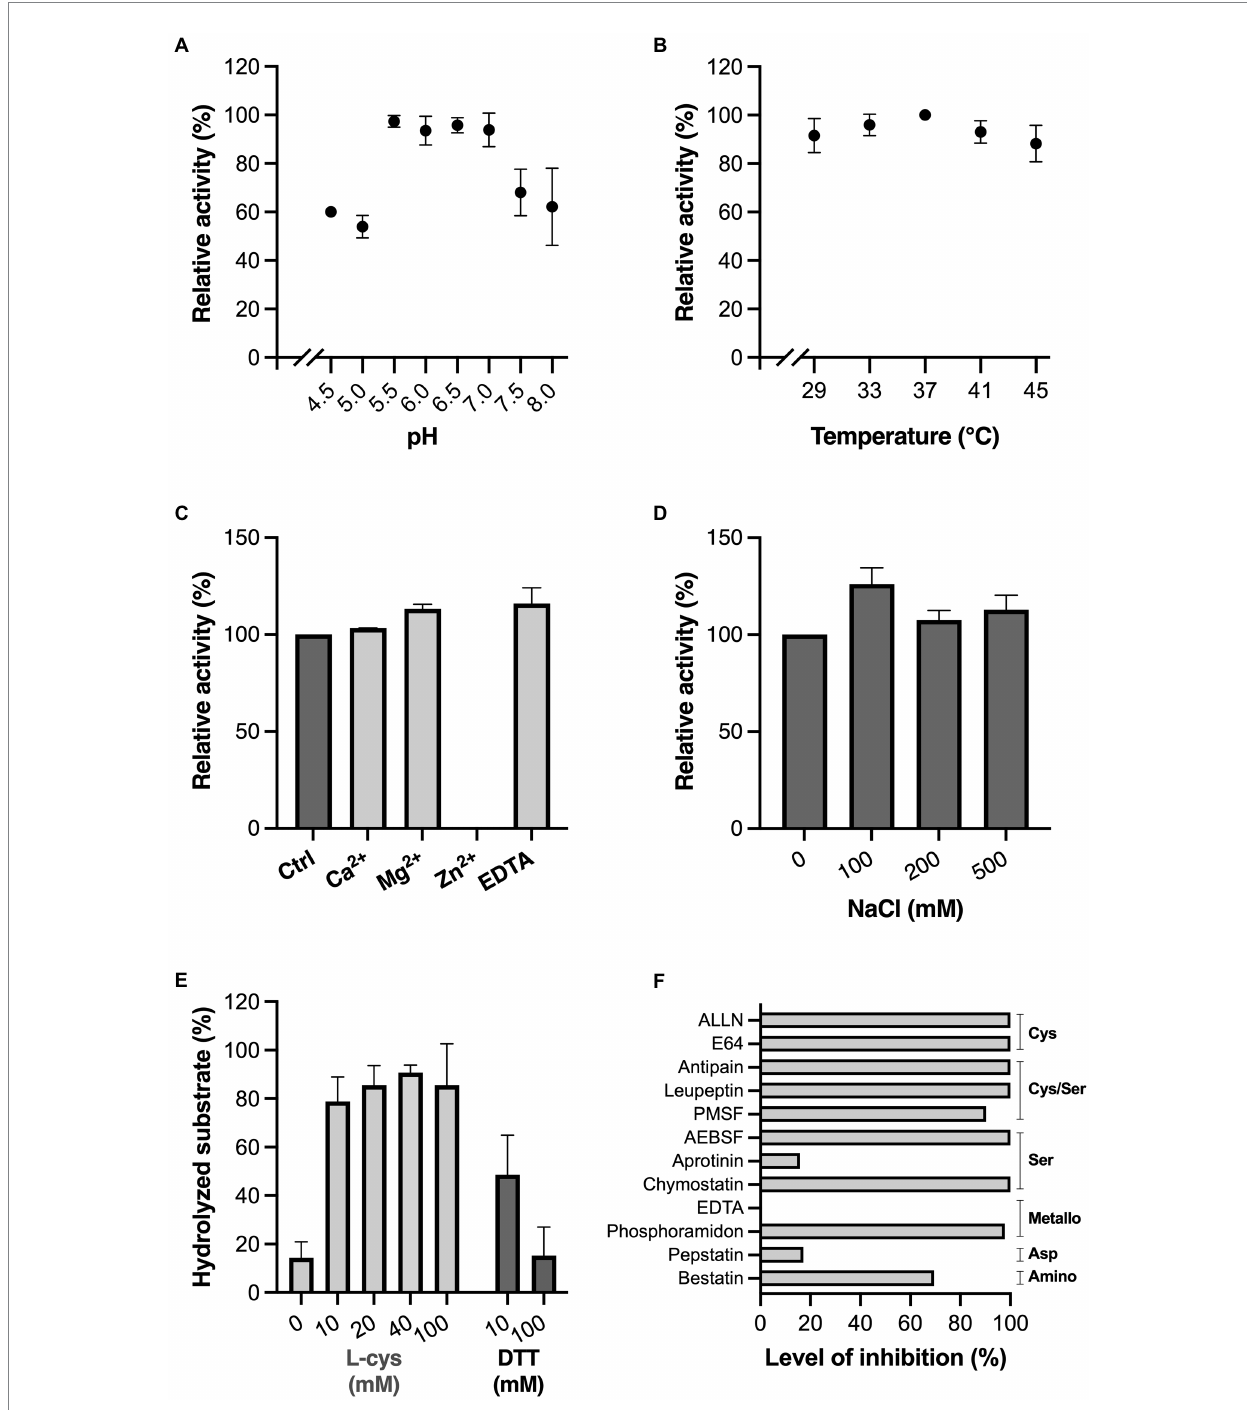
FIGURE 2 Influence of physicochemical conditions and inhibitors on MdpL activity. Effect of (A) pH, in the interval 4.5–8.0, (B) biologically relevant temperatures (29–45 ° C), (C) 2 mM Ca 2+ , Mg 2+ , Zn 2+ , and EDTA, (D) increasing NaCl concentrations (0–500 mM), (E) the reducing agents L-cys and DTT at increasing concentrations (0, 10, 20, 40, 100 mM, and 10, 100 mM, respectively), (F) common protease inhibitors, where the inhibition level is displayed